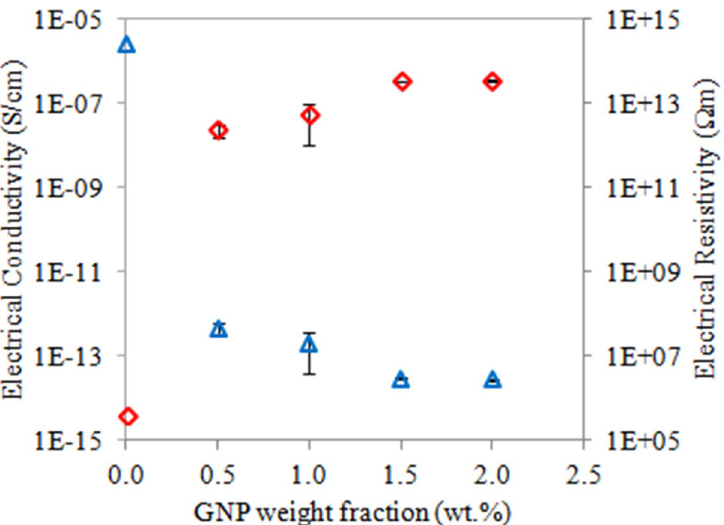
Fig 8. Electrical conductivity and resistivity of the neat TPNR sample and TPNR/GNP with different nanofiller weight fractions.